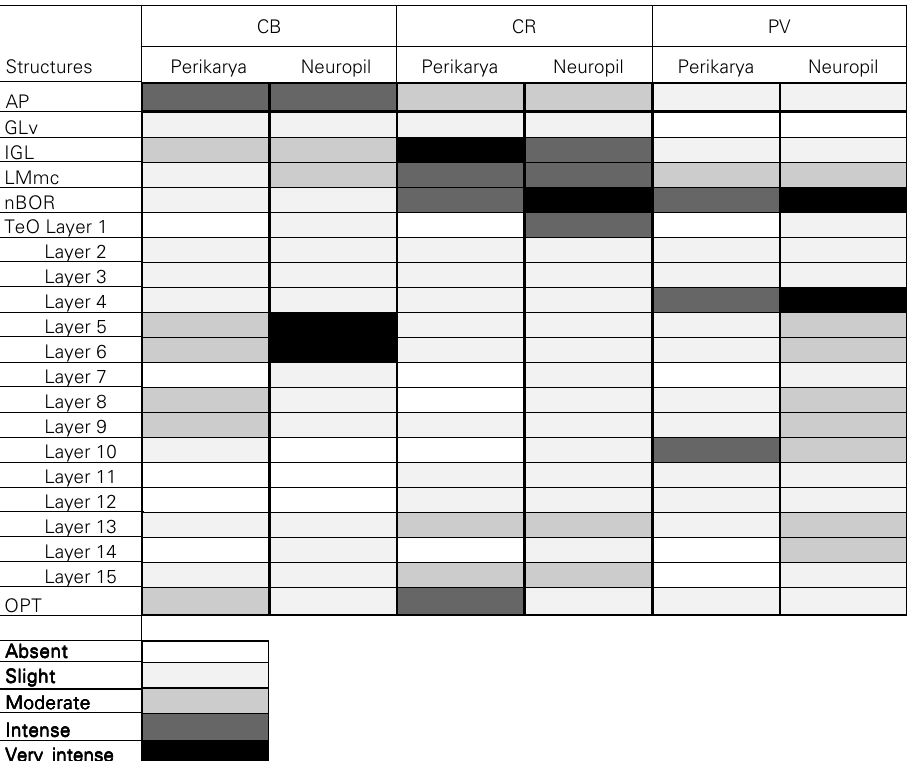
Table 1 - Distribution of the calcium-binding proteins calbindin (CB), calretinin (CR) and parvalbumin (PV) in retinorecipient areas of the chick brain. AP, Area pretectalis; GLv, nucleus geniculatus lateralis, pars ventralis; IGL, intergeniculate leaflet; LMmc, nucleus lentiformis mesencephali, pars magnocellularis; nBOR, nucleus of the basal optic root; TeO, tectum opticum; OPT, nucleus opticus principalis thalami. CB CR